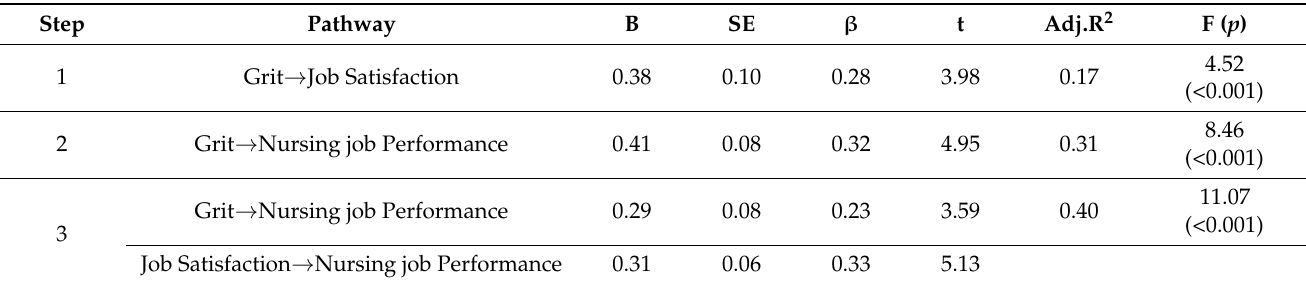
Table 3. The mediating effect of job satisfaction and organizational commitment in the relationship between grit and nursing job performance of